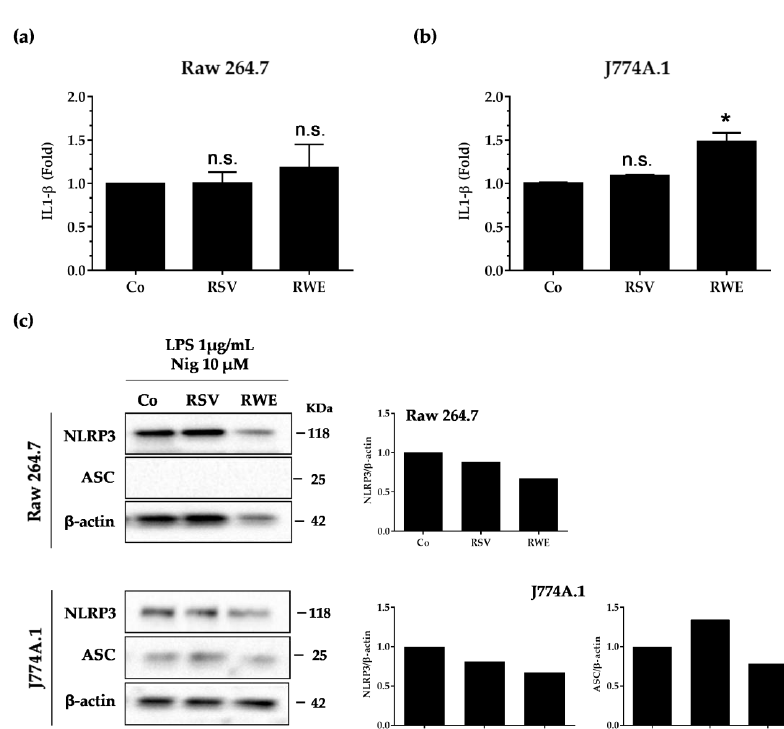
Figure 4. RWE and RSV failed to block IL-1 β secretion when added after the NLRP3 priming step. Raw 264.7 ( a ) and J774A.1 ( b ) macrophages were exposed to 1 µ g/mL of LPS for 5.5 h, then treated or not with RWE (100 µ g/mL) or RSV (60 µ M) for 30 min and finally exposed for an additional 30 min to 10 µ M nigericin. Secreted IL-1 β in cell supernatants was analyzed by ELISA at the end of the treatments. Data are expressed as fold changes in secreted IL-1 β levels as compared to cells treated only with LPS + nigericin (Co) and are mean ± s.d. of three independent experiments. p -values were determined by the multiple Student t test. * p < 0.05, n.s.: not significant. ( c ) Western blot analysis of NLRP3 and ASC protein expression in Raw 264.7 and J774A.1 macrophages after cell treatments as described above. Left panels: representative blots from three independent experiments are shown. β -actin was used as loading control. Right panels: quantifications by densitometry of representative blots. Plotted data are fold changes as compared to LPS-treated cells